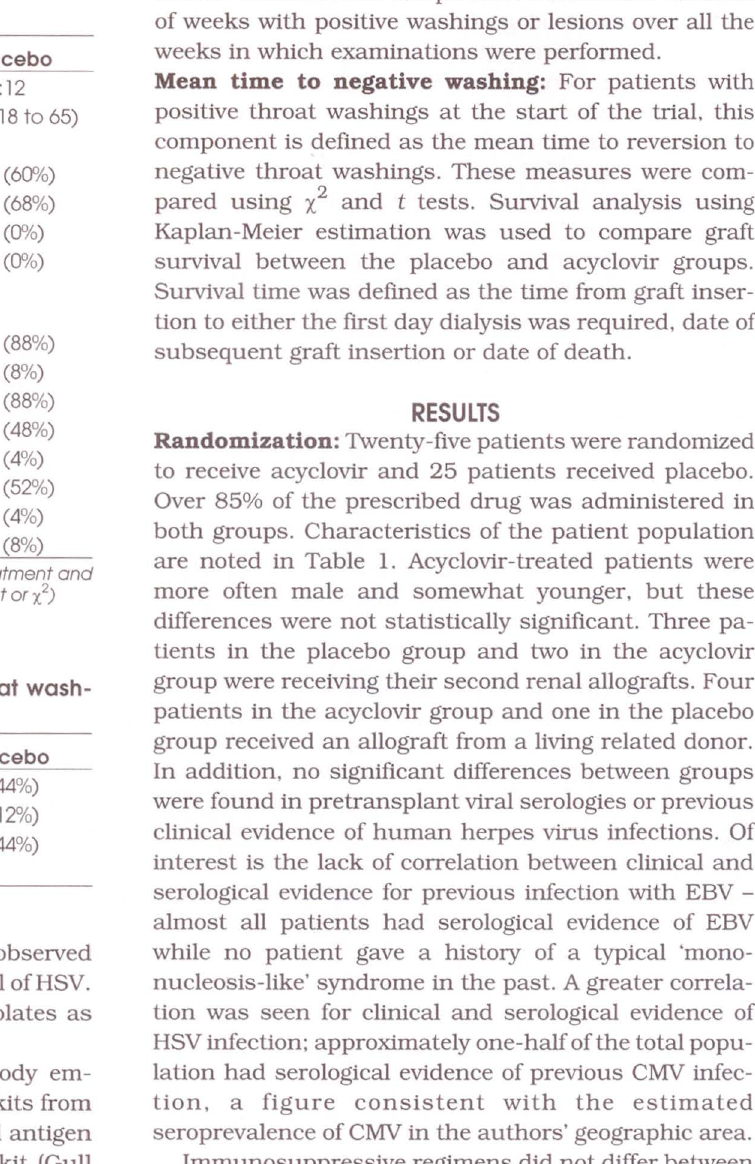
Periods of positive herpes simplex virus in throat wash ings during the